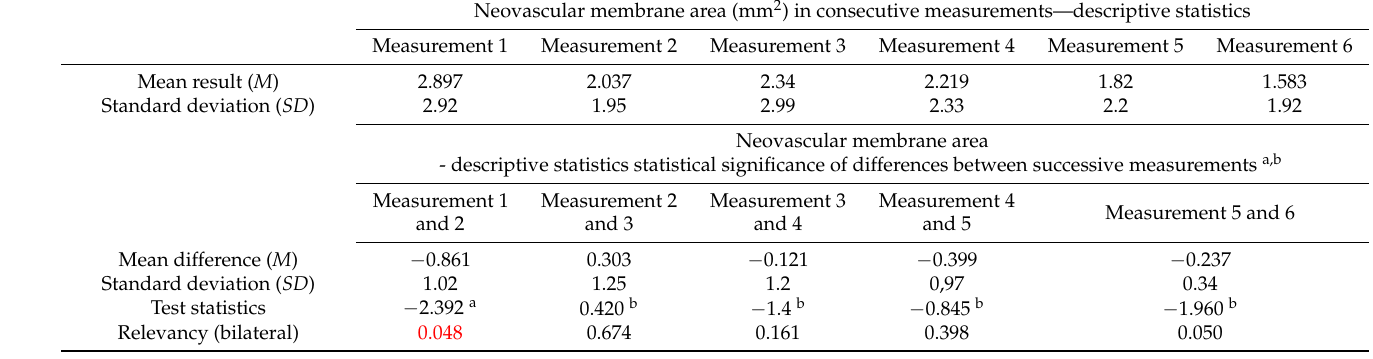
Table 4. Neovascular membrane area-descriptive statistics and statistical significance of